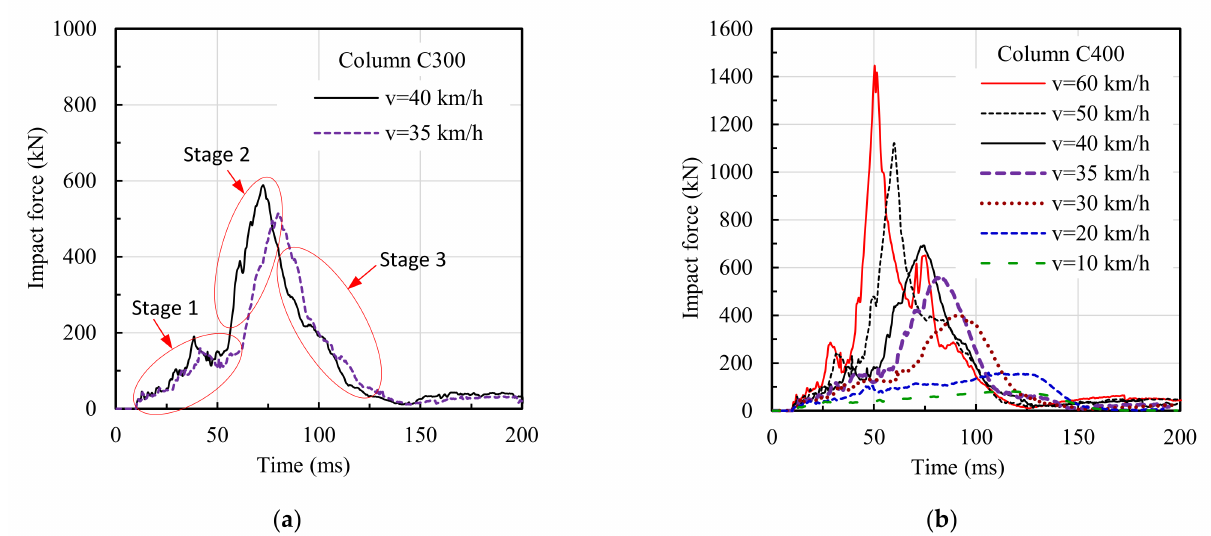
Figure 11. Impact force-time histories at the event of car–column collision: ( a ) typical impact force- time history showing different stages of the impact event; ( b ) impact force-time histories for different car crashing